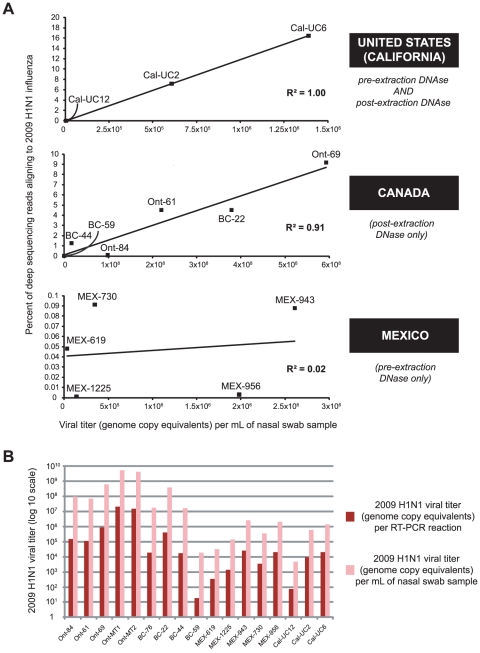
Relationship between percentage of deep sequencing reads aligning to 2009 H1N1 and viral titer.(A) For each sample, the percentage of deep sequencing reads aligning to 2009 H1N1 is plotted as a function of the calculated viral titer (genome copy equivalents) per mL of nasal swab sample, and a linear regression line is fitted to the data. Samples are stratified by originating location and method of DNase treatment. (B) For each of the 17 samples, the calculated 2009 H1N1 viral titer (genome copy equivalents) per RT-PCR reaction (dark red) or per mL of nasal swab sample (pink) is shown.